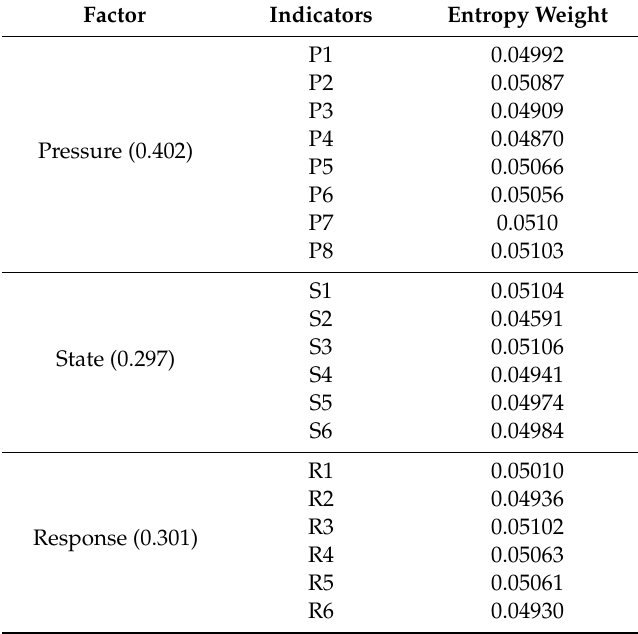
Table 3. Weight results of the index system for urban river health